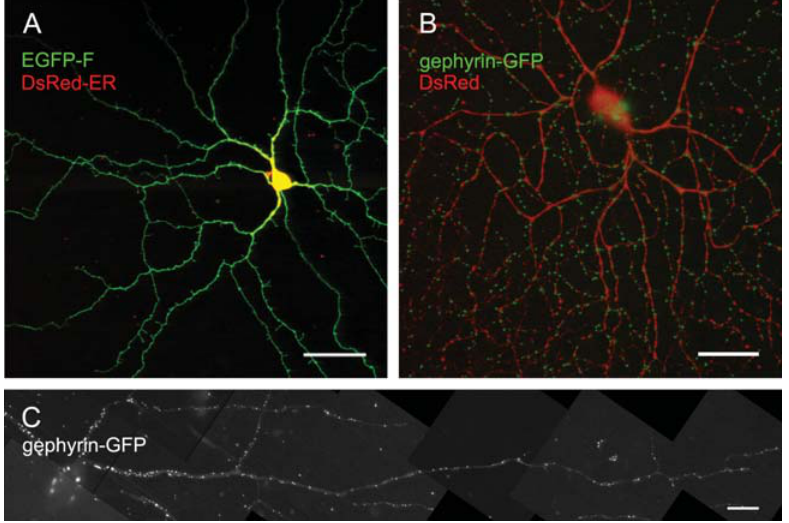
Figure 5. Expression of markers for subcellular structures in retinal ganglion cells. ( A ) Single confocal image plane of a large ON ganglion cell transfected with expression plasmids for EGFP-F (labeling the cell membrane) and DsRed2-ER (labeling the endoplasmic reticulum.) Scale bar, 50 m m. ( B ) Volume reconstruction of a confocal image stack of a large ganglion cell transfected with the cell-filling marker HcRed and a marker for postsynaptic densities of inhibitory synapses, gephyrin-GFP (green). Scale bar, 50 m m. ( C ) A single dendrite of an OFF alpha ganglion cell transfected with gephyrin-GFP. Note the high density of puncta particularly on the proximal dendrites. Scale bar, 20 m m.